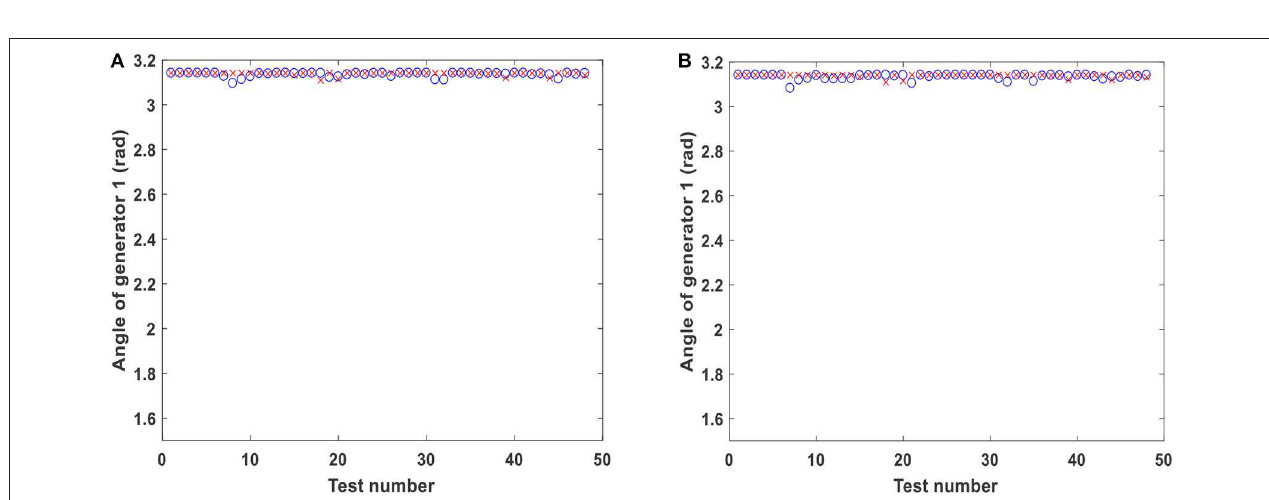
FIGURE 15 | (A) Results with 98 variables; (B) Results with 11 key variables under 79% wind penetration. O = Estimation; X = Simulation.